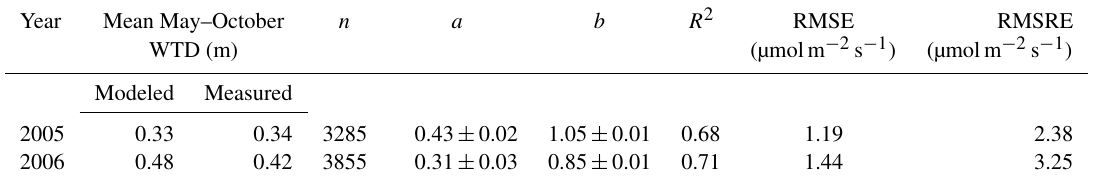
WTD: water table depth below the hummock surface; ( a,b) from simple linear regressions of modeled on measured ( ± standard errors) and R 2 : coefficient of determination; RMSE: root mean square for errors from simple linear regressions of measured on simulated; RMSRE: root mean square for